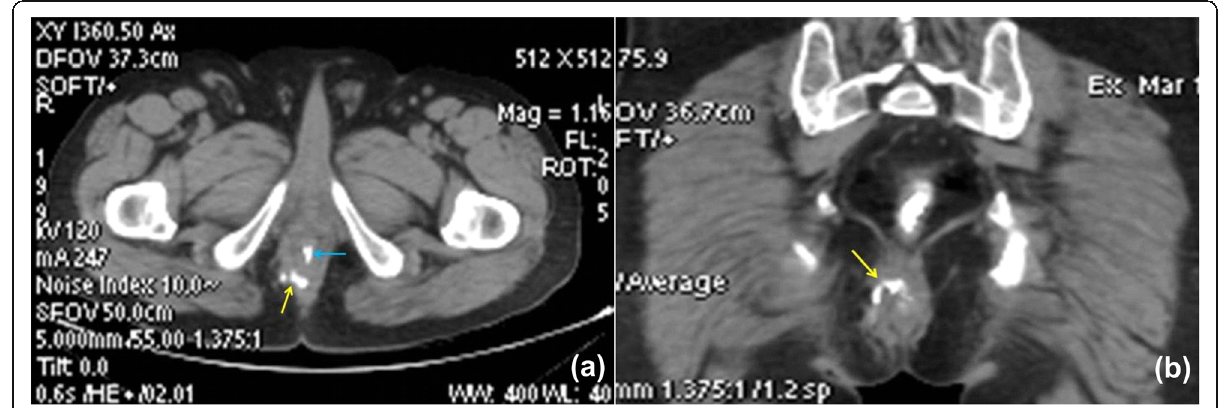
Fig. 5 CT fistulogram of a transsphincteric fistula in ano on the right perianal region with upper and lower arms and internal openings in both anterior and posterior midline. a Transverse image showing lower arm of the track entering into the anal canal posteriorly (yellow arrow) with contrast in the rectum (blue arrow). b Coronal image showing upper arm of the track entering into the anal canal